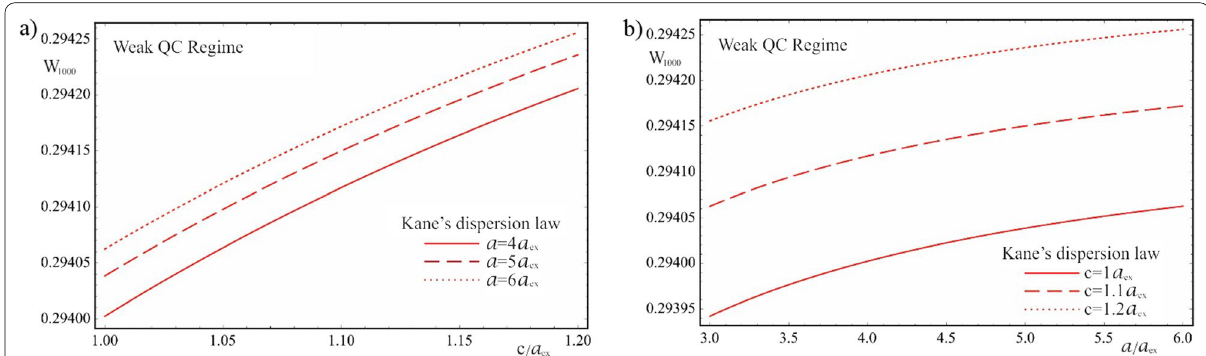
Fig. 14 The dependences of the AE for the Kane’s dispersion law of CCs in the weak quantum confinement regime: ( a ) on the minor semiaxis c at the different values of the major semiaxis a , ( b ) on the major semiaxis a at the different values of the minor semiaxis c